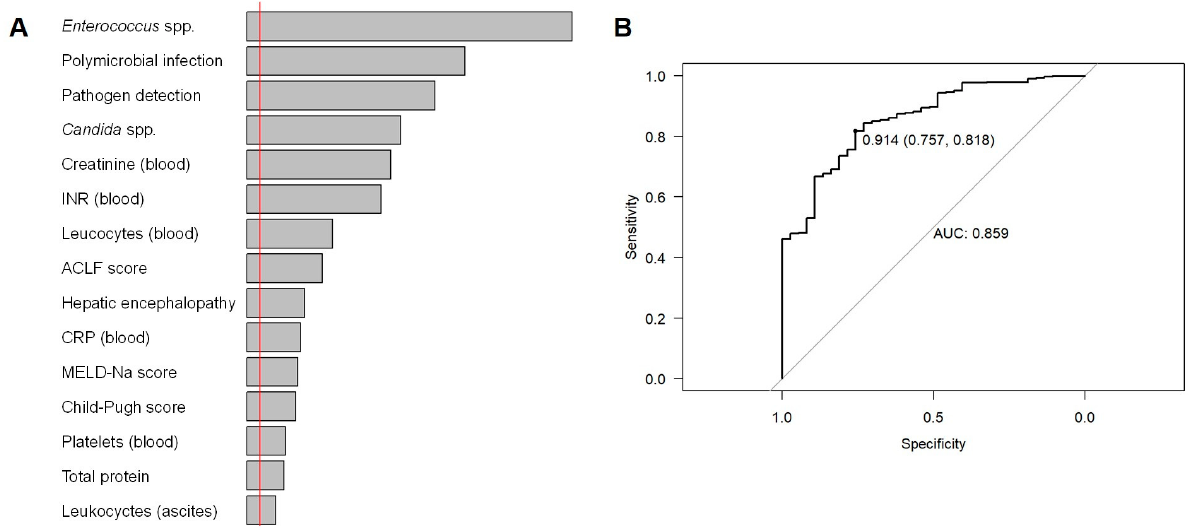
Figure 2. Random forest analysis. ( A ) Most important features based on random forest analysis (red line: absolute value of the lowest observed negative importance measure). ( B ) Receiver operating curve (ROC) and area under the curve (AUC) = 0.859. ACLF, acute-on-chronic liver failure; CRP, C-reactive protein; INR, international normalised ratio; MELD-Na, model for end-stage liver disease with serum sodium.